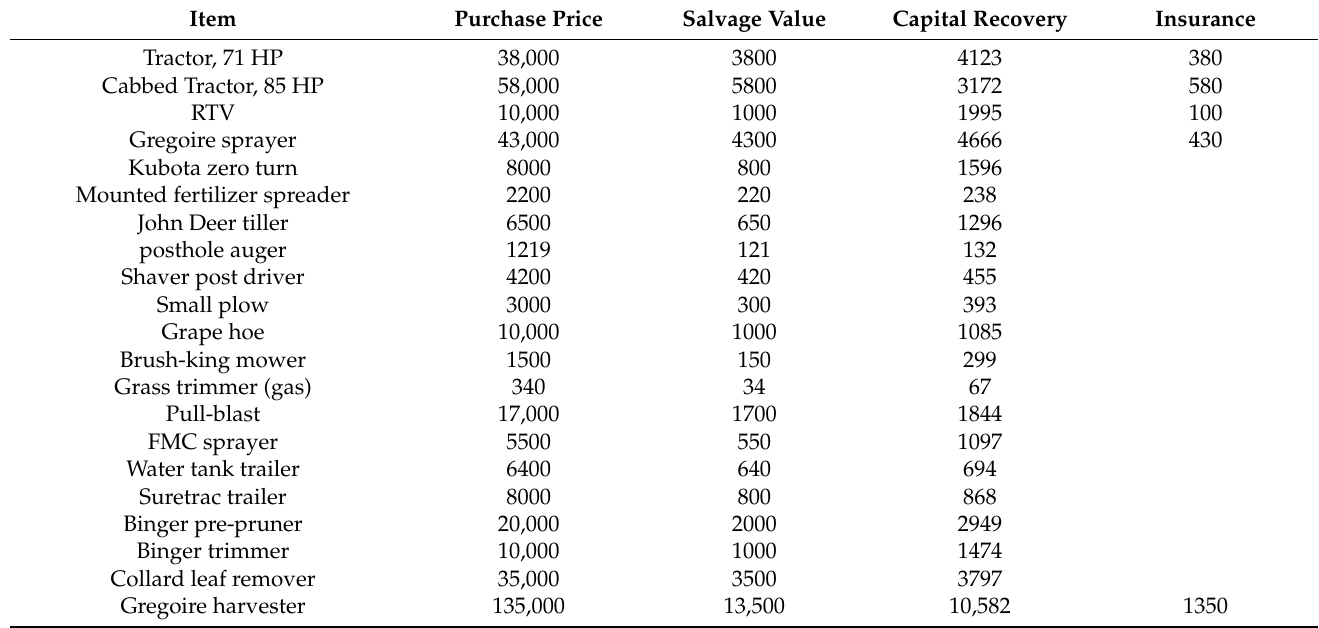
Table 7. List of machinery and equipment considered in the sample budget for a vinifera